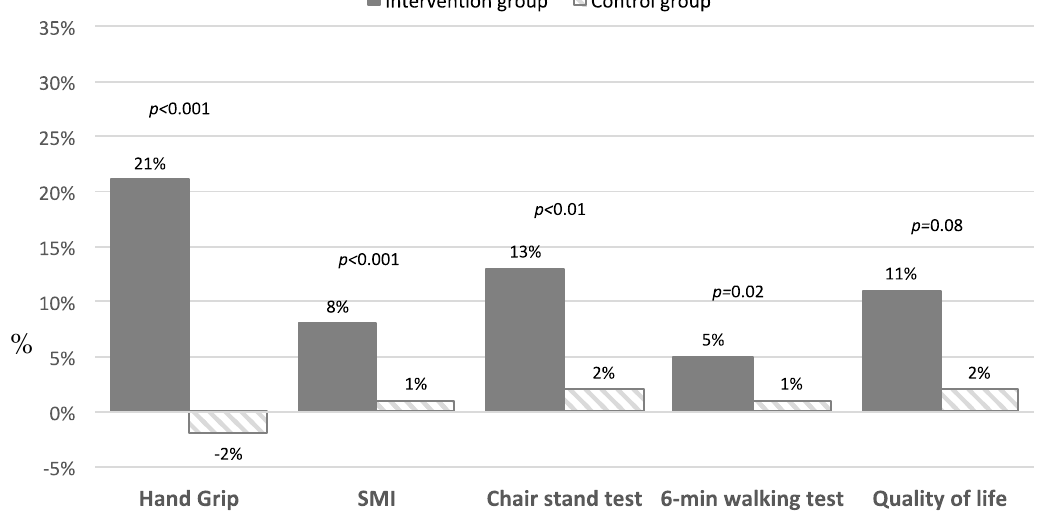
Figure 2. Percentage changes in skeletal muscle index, physical performance measures, and quality of life between baseline and follow-up.